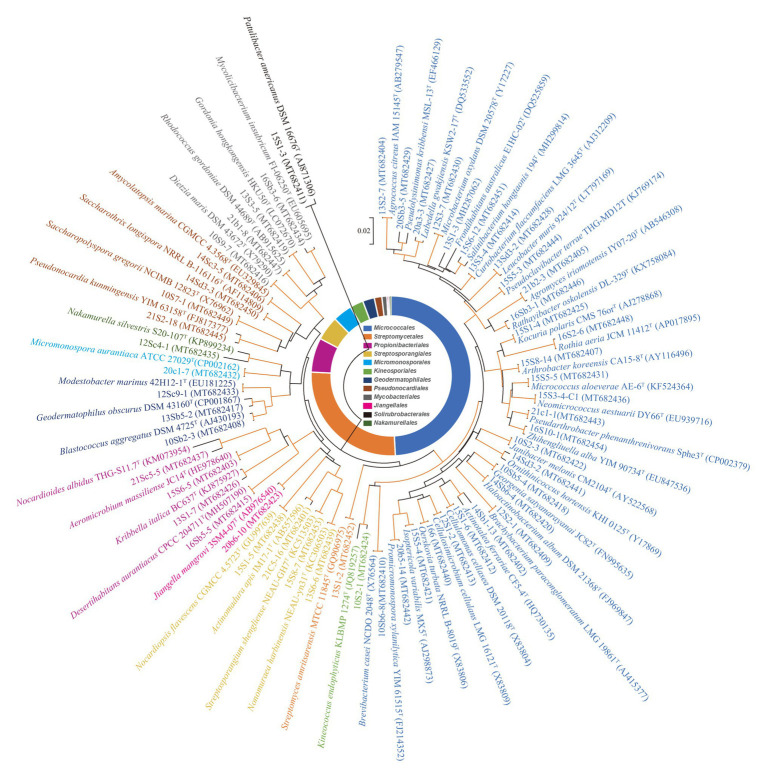
Phylogenetic tree based on 16S ribosomal RNA (rRNA) genes using neighbor-joining method with 1,000 bootstrap replications for 55 representative actinobacterial strains and their closely related type strains. Red lines indicate bootstrap support values >70% for the branch. Strains in the same color belong to the same order. Bar, 2 nt substitutions per 100 nt.